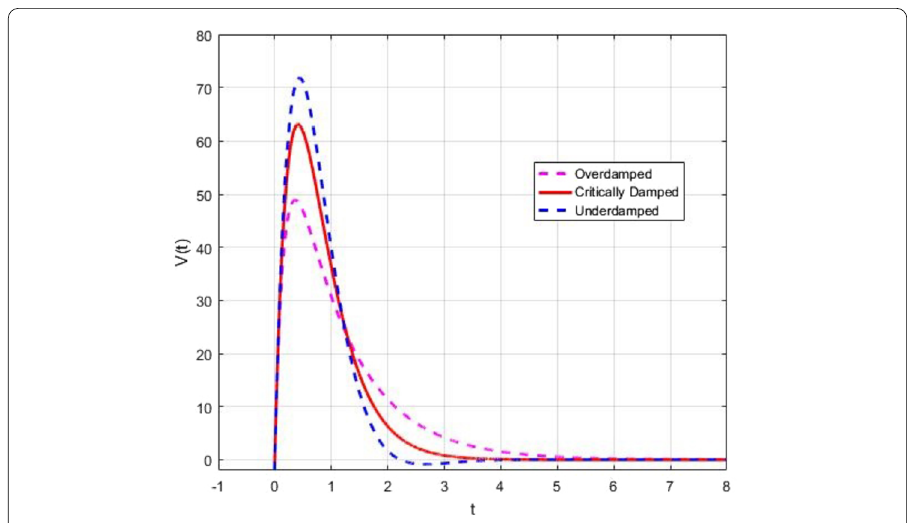
Figure 3 Graph of transient response in overdamped, critically damped and underdamped case